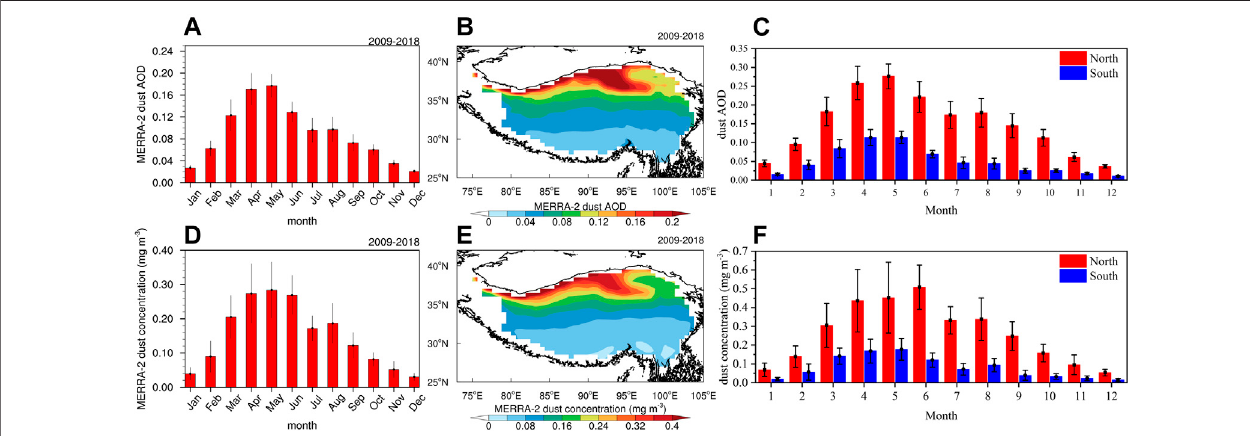
FIGURE 4 | Spatial distributions of dust concentration over the TP in (A) MAM and (B) DJF for 2009 – 2018 derived from MERRA-2 reanalysis datasets; spatial distributions of dust concentration linear trends (units: mg m − 3 month − 1 ) over the TP in (C) MAM and (D) DJF for 2009 – 2018 from MERRA-2 reanalysis datasets. Regions passing the 95% signi fi cance level are highlighted by stipple. Signi fi cance is assessed through the t value of the ensemble trend.